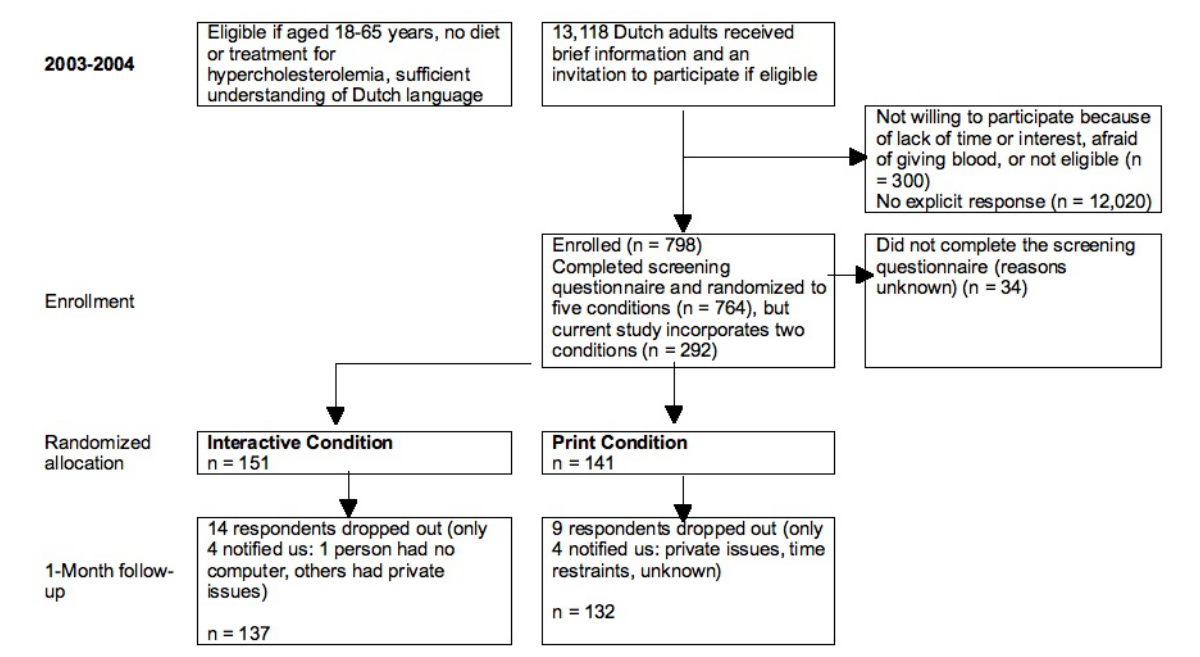
Figure 1. Subject recruitment and retention